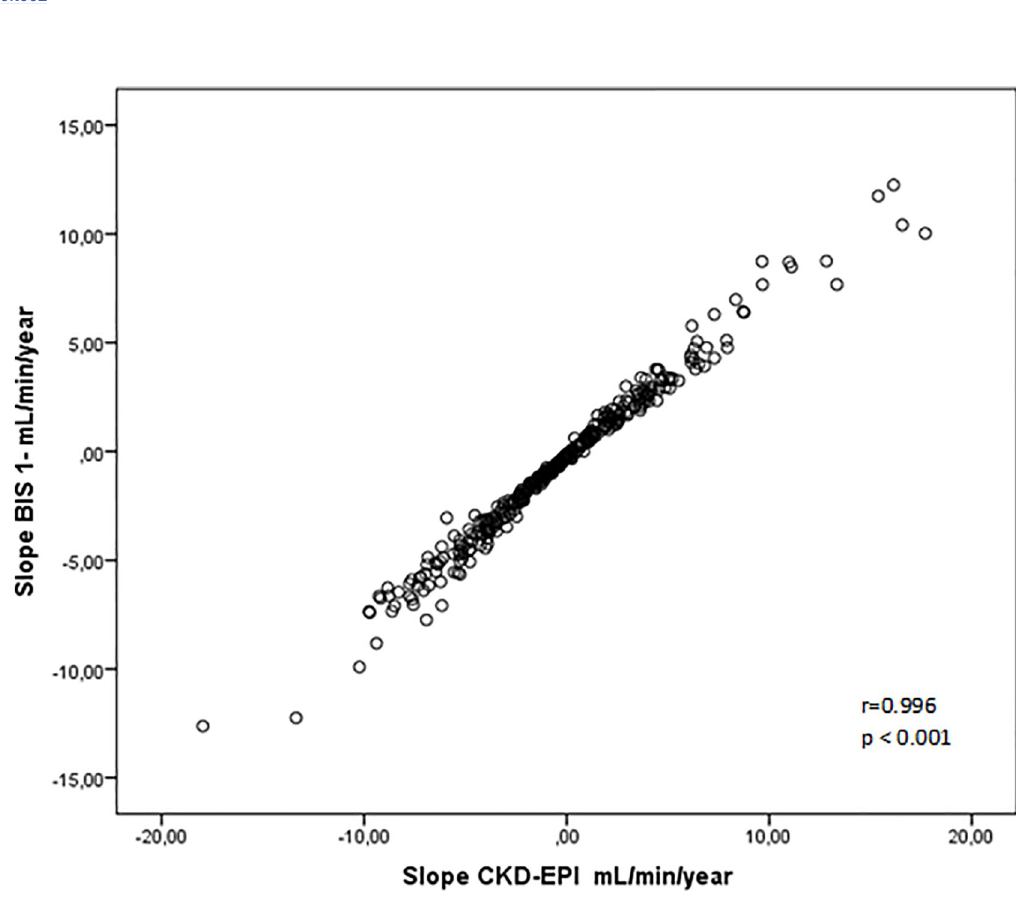
Fig 3. Correlation between BIS-1 slope and CKD-EPI